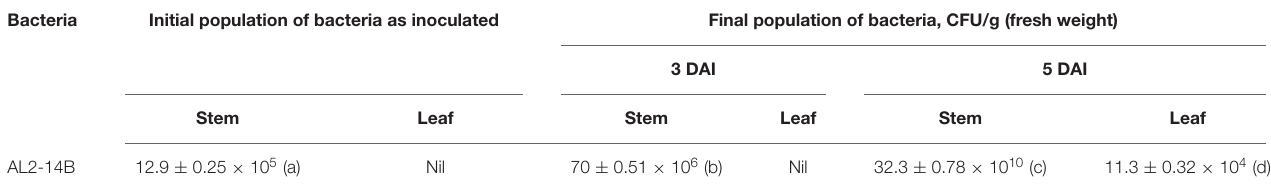
Values with different letter within a row are significantly different from initial population at P <